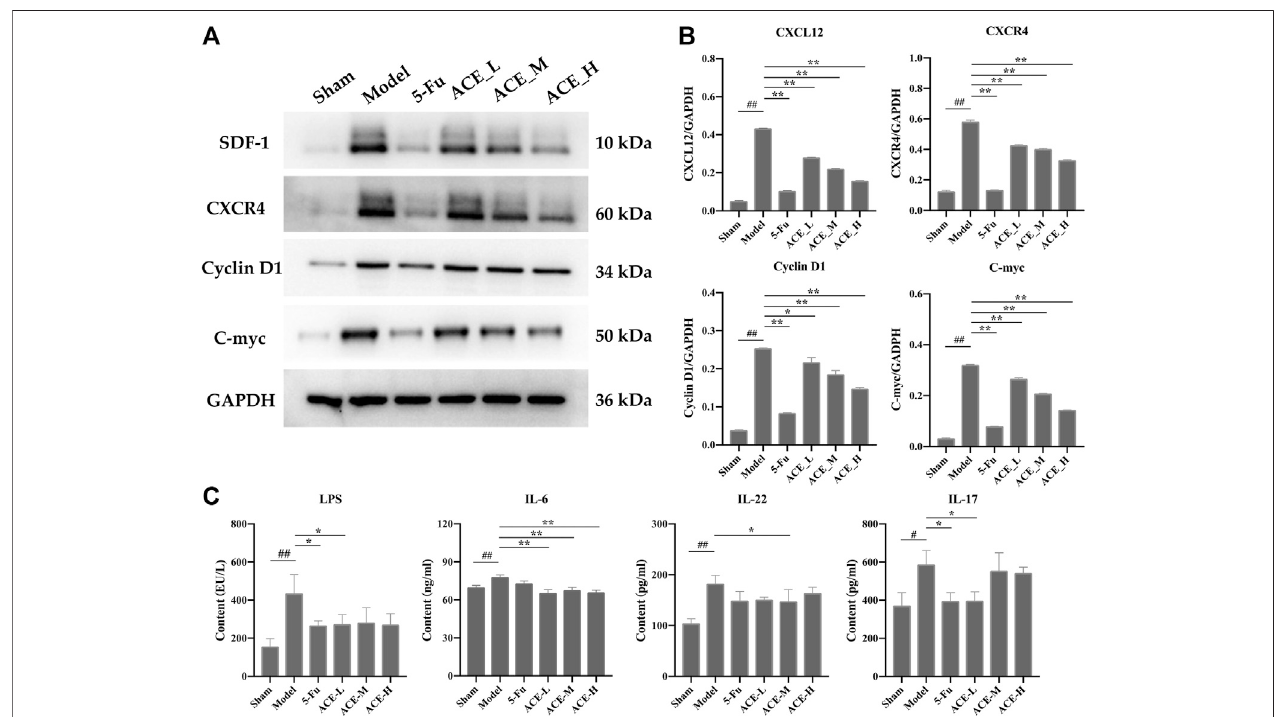
FIGURE 6 | The effect of Astragalus mongholicus Bunge- Curcuma aromatica Salisb. extract on SDF-1/CXCR4 and in fl ammatory factors in colon cancer-bearing mice. (A) Greyscalestrips of SDF-1, CXCR4, Cyclin D1and C-myc detected byWB; (B) Proteinexpression ofSDF-1, CXCR4, CyclinD1 and C-myc; (C) Thecontentof LPS, il-6, IL-22 and IL-17A in serum detected by ELISA. # p < 0.05 and ## p < 0.01, compared with the sham group; * p < 0.05 and ** p < 0.01, compared with the model group. n (cid:2) 10.